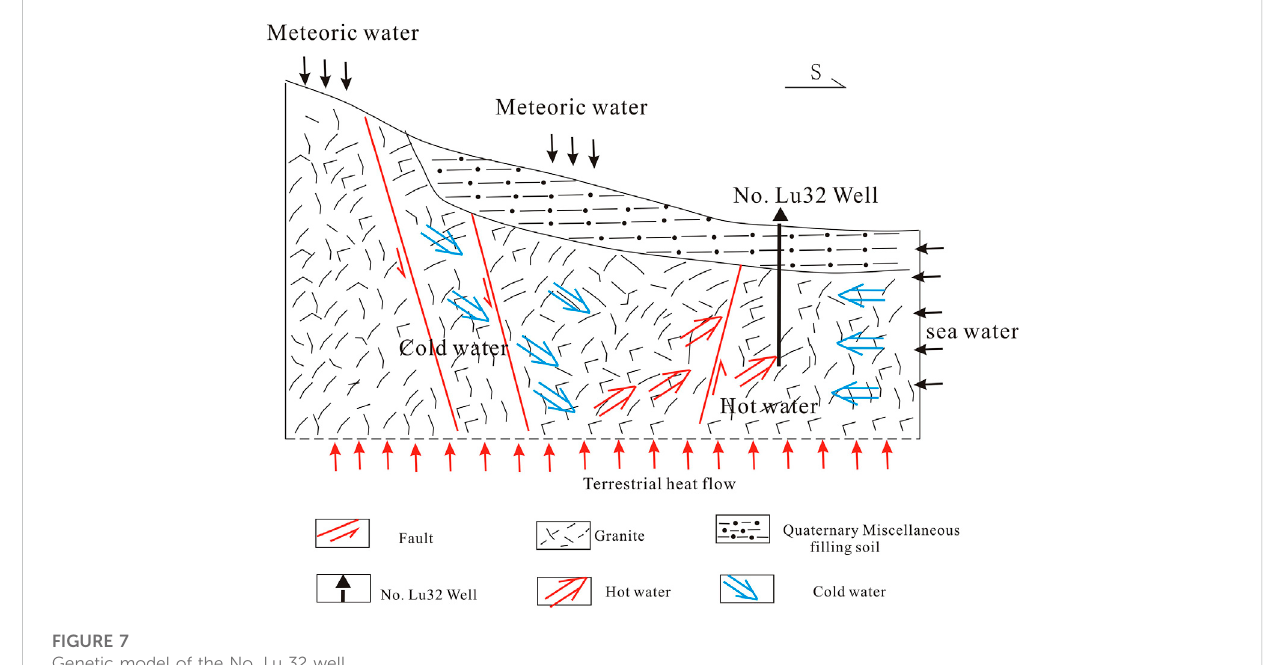
FIGURE 7 Genetic model of the No. Lu 32